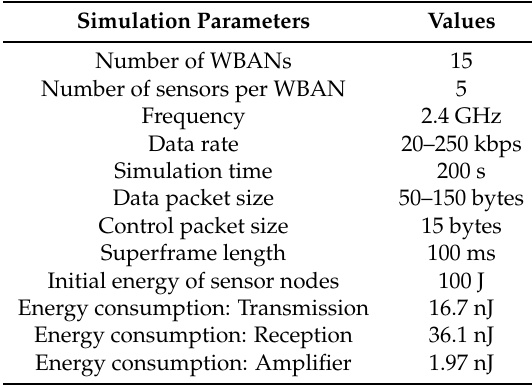
Table 2. Simulation parameters.